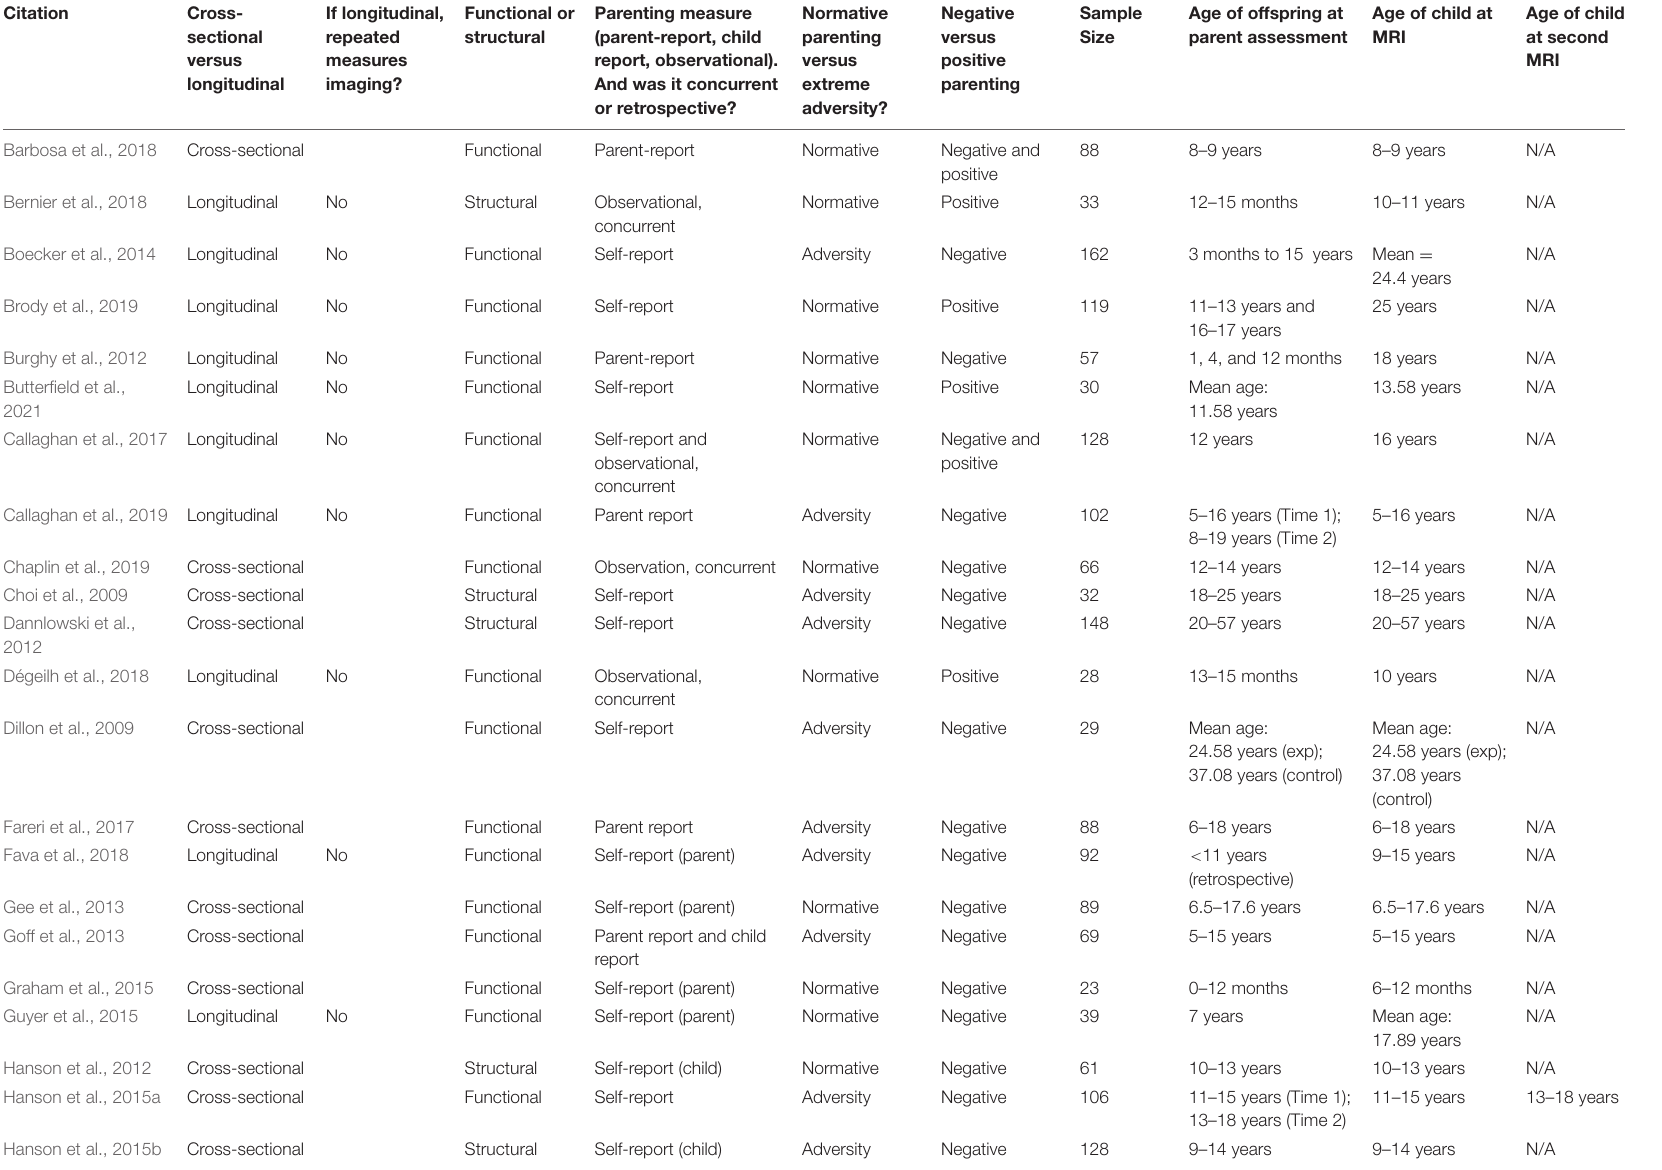
TABLE 1 | Methodological summary of studies included in this